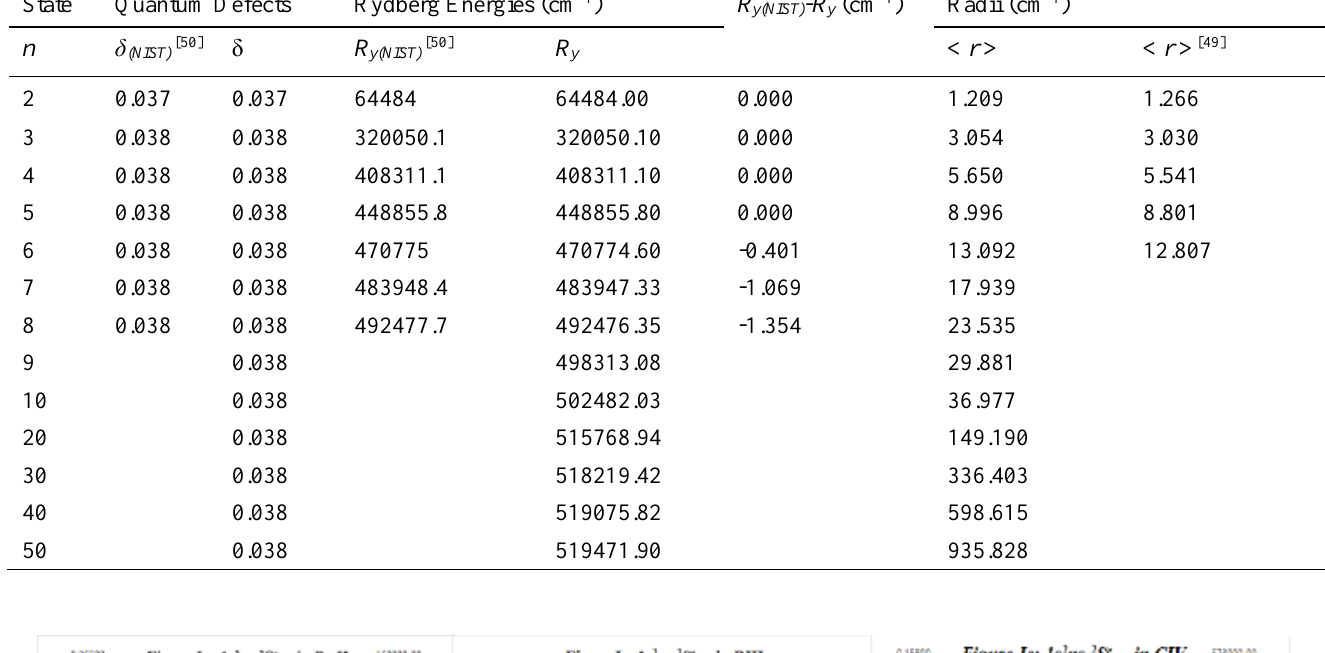
Spectral Rydberg Energy Series with Quantum Defects and Radii of Li iso-electronic sequence in 1 s 2 np 2 P o 1/2 (C IV)